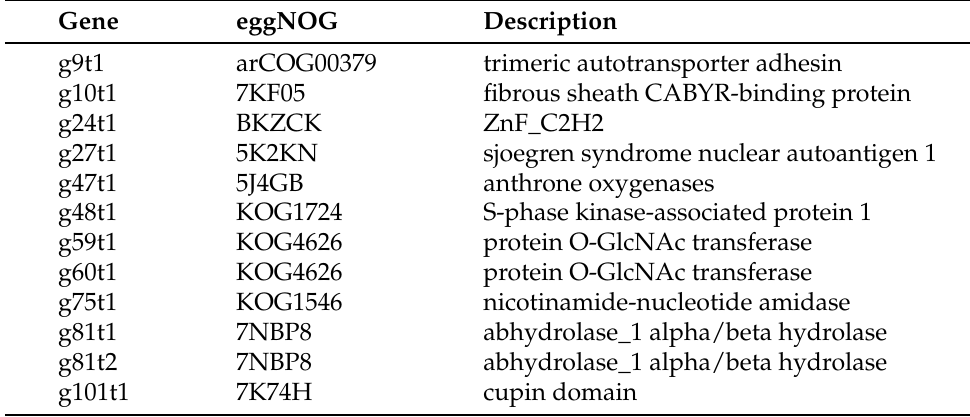
Table A4. Putative proteins of F. circinatum annotated by